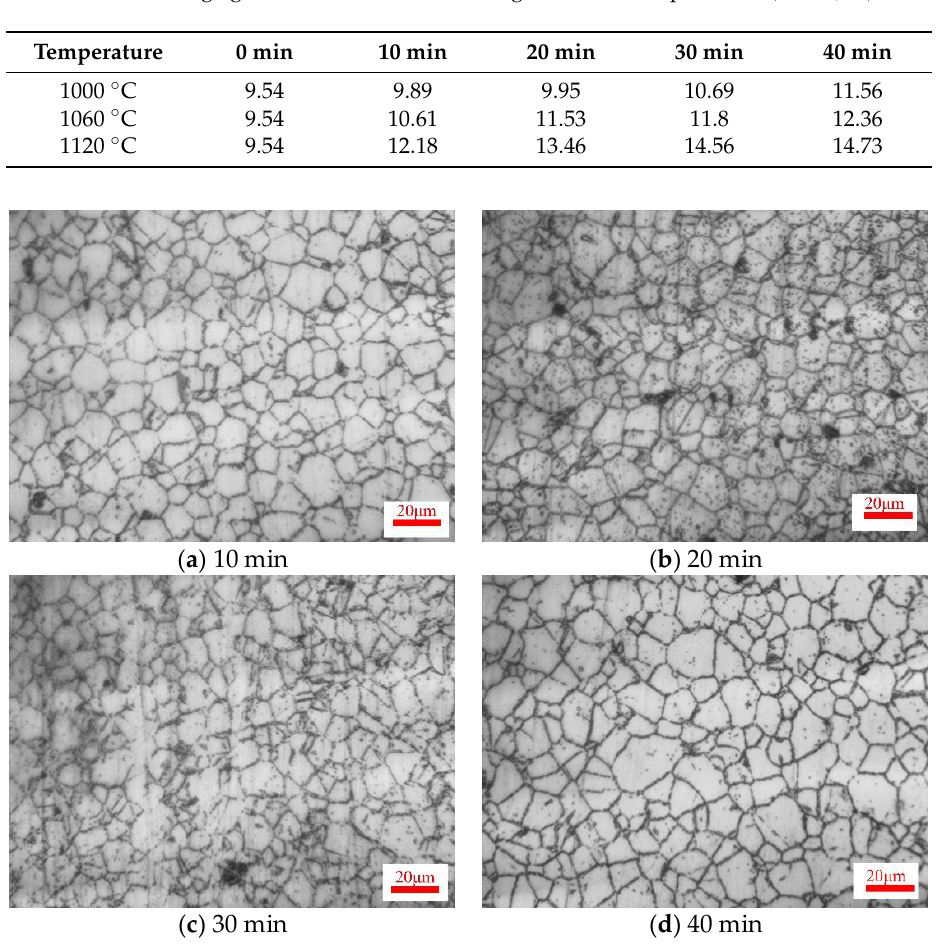
Figure 4. Microstructures of 21-4N at 1120 °C with different holding times.